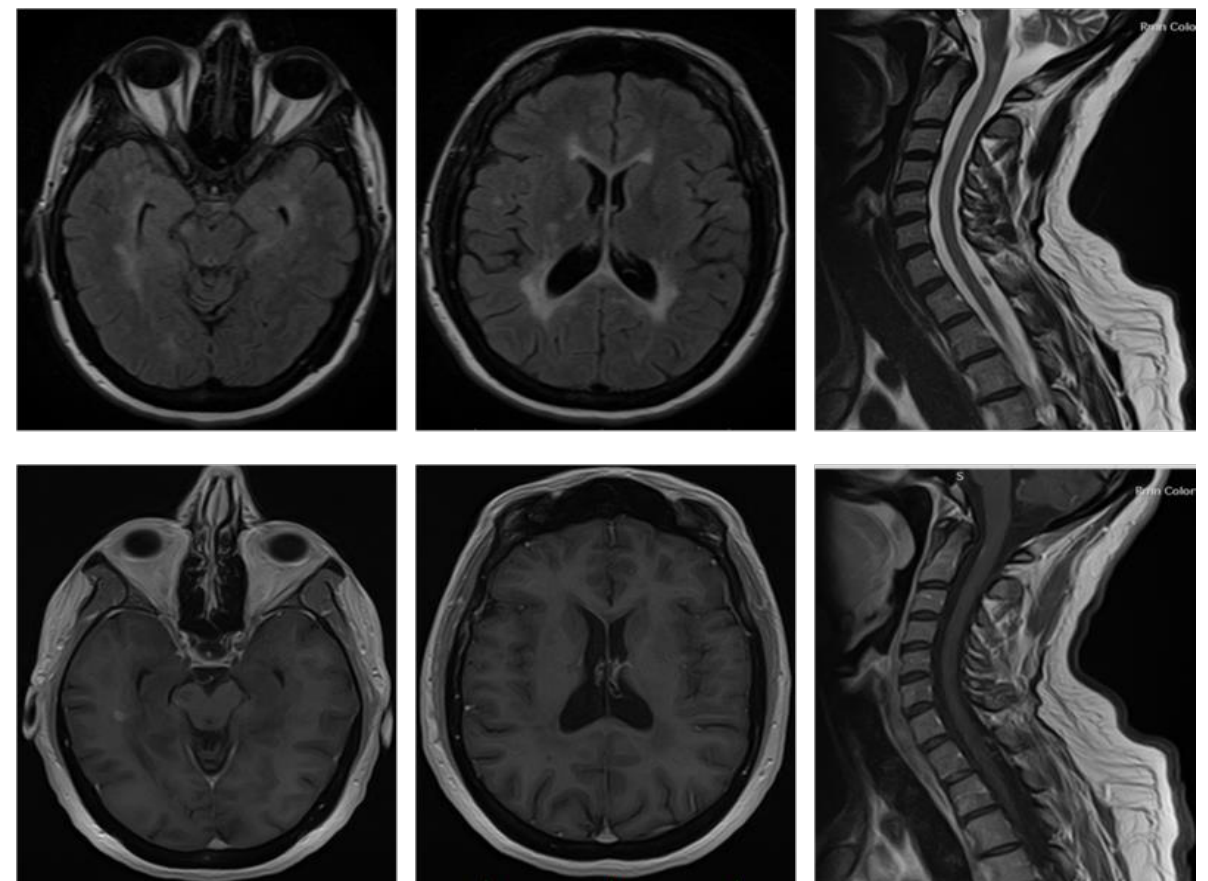
Figure 2. Case Report 2: T2-weighted sequences (top row) and T1-weighted post-gadolinium (bottom row) of brain and spinal cord MRI scan acquired at MS symptom onset.